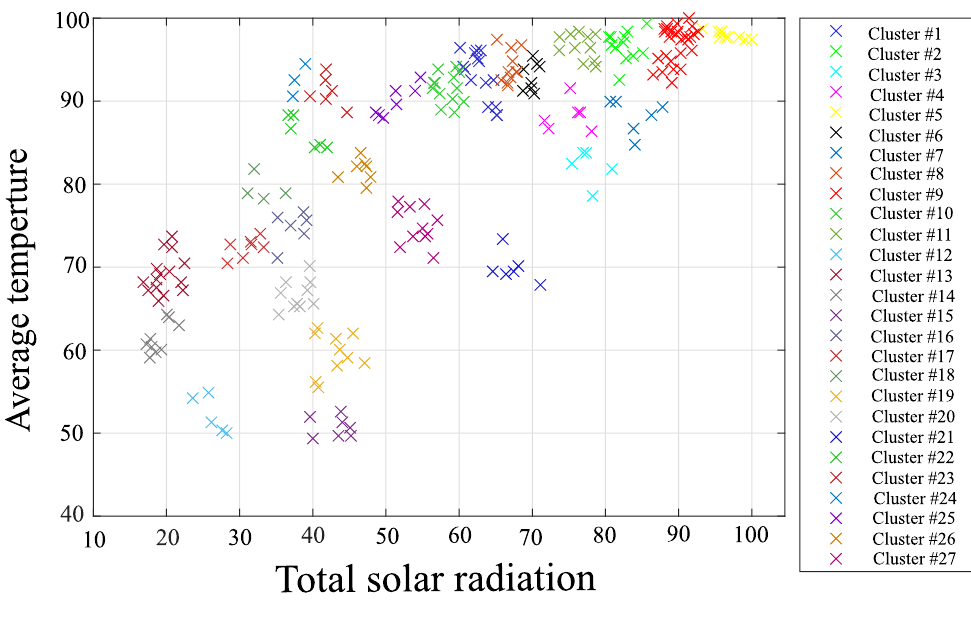
Figure 19. Step 9